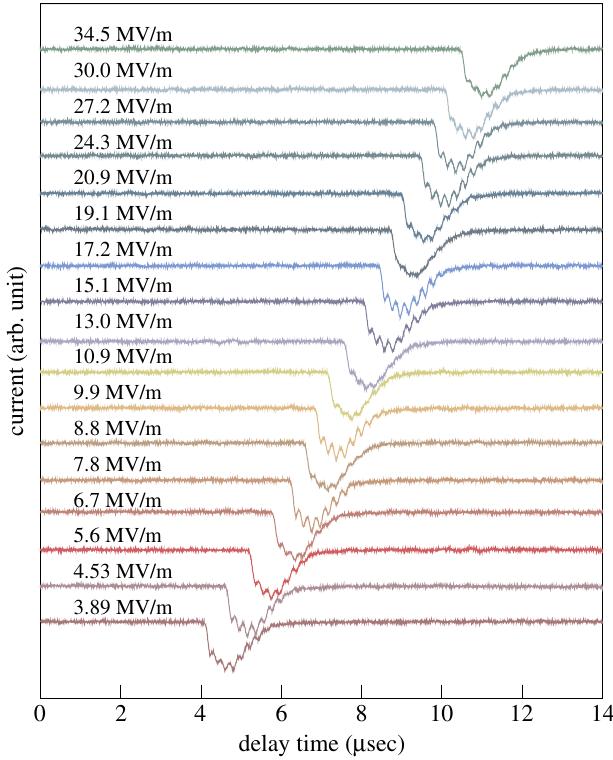
FIG. 8. (Color) Faraday cup signal as a function of the time elapsed since the end of the rf pulse for different values of the maximum rf field at the cathode. The delay ( t end of the rf pulse and the start of the rear multipacting peak decreases as the maximum rf field decreases. The peak ampli- tude of the multipacting current spike does not change visibly with respect to the maximum rf